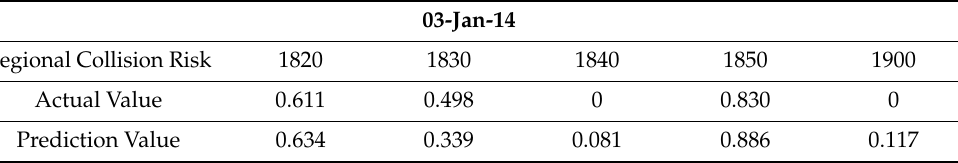
Table 5. 03-Jan-14 Regional Collision